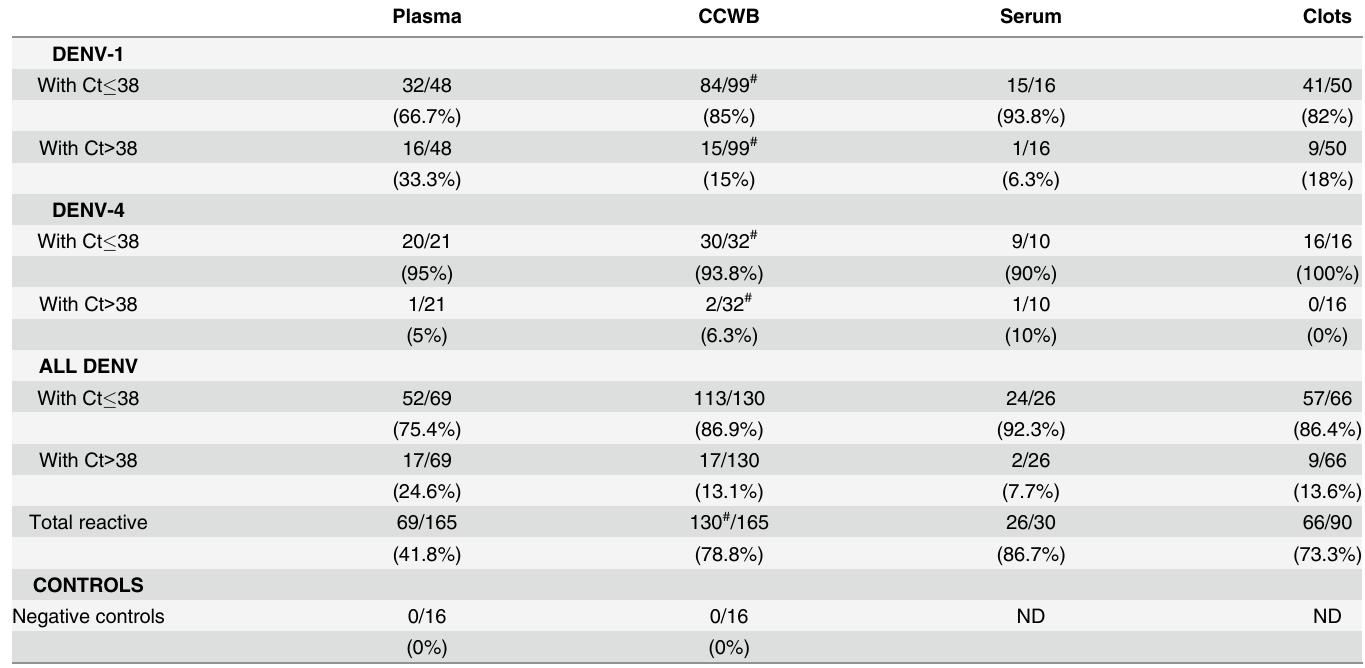
Table 1. Summary of DENV testing by TaqMan in plasma, cellular component of whole blood, serum and clot specimens from blood donors from Puerto Rico, 2012 – 2013, n = 165, and negative controls from the contiguous U.S., n = 16. Plasma CCWB Serum DENV-1